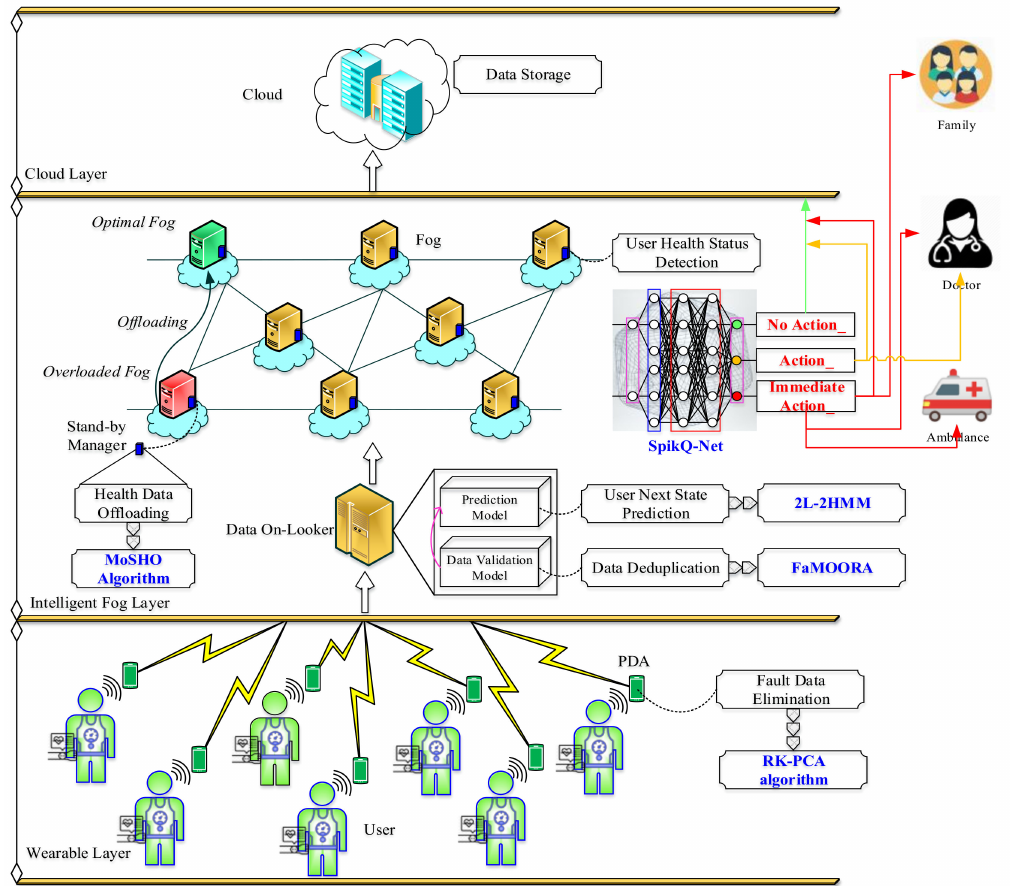
Figure 1. Tri-FogHealth System